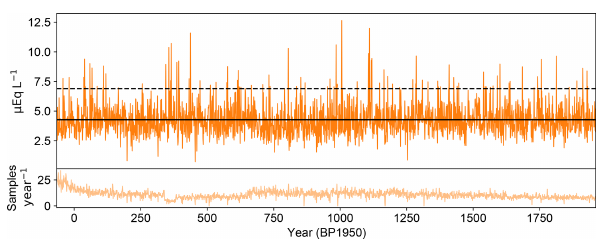
Figure 10. Time series for annually averaged chloride. Solid black line indicates the 2000-year mean value. Dashed black line indi- cates 2 σ value. The lower panel indicates the number of individual samples in the year used for the average